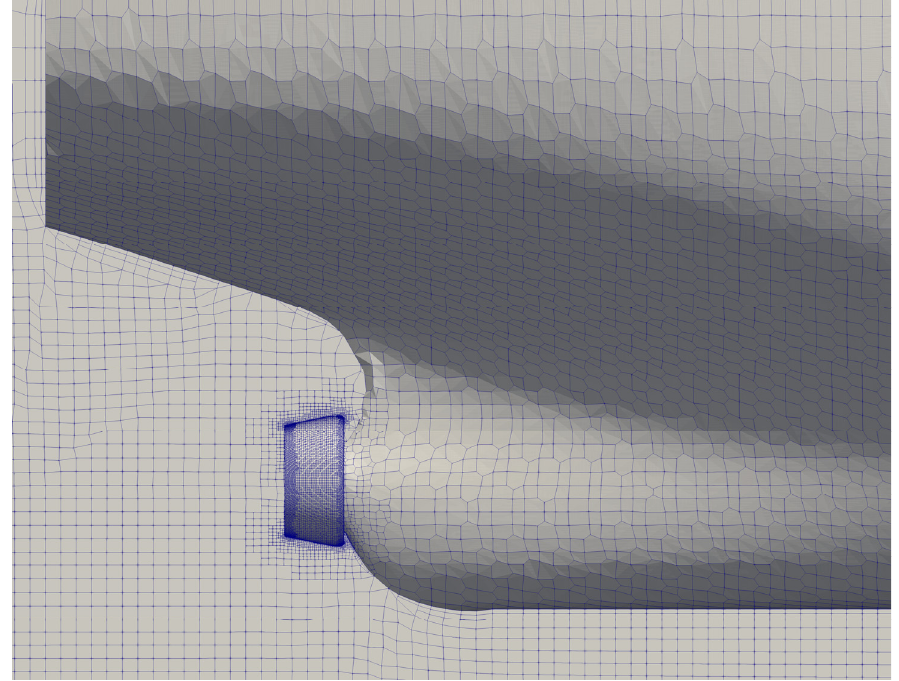
Figure 8. Grids around the ship stern and optimal duct.